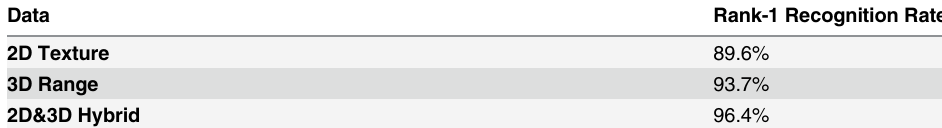
Table 2. Rank-one reognition rates on different data types.